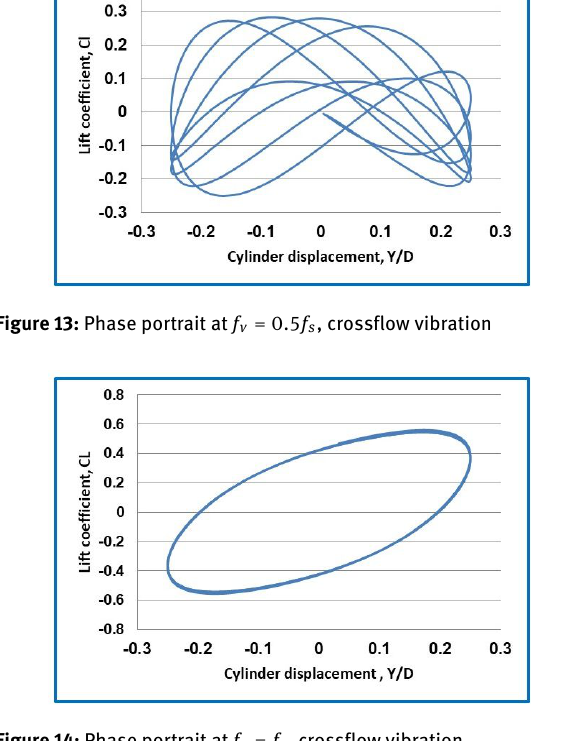
Figure 14: Phase portrait at f v = f s , crossflow vibration